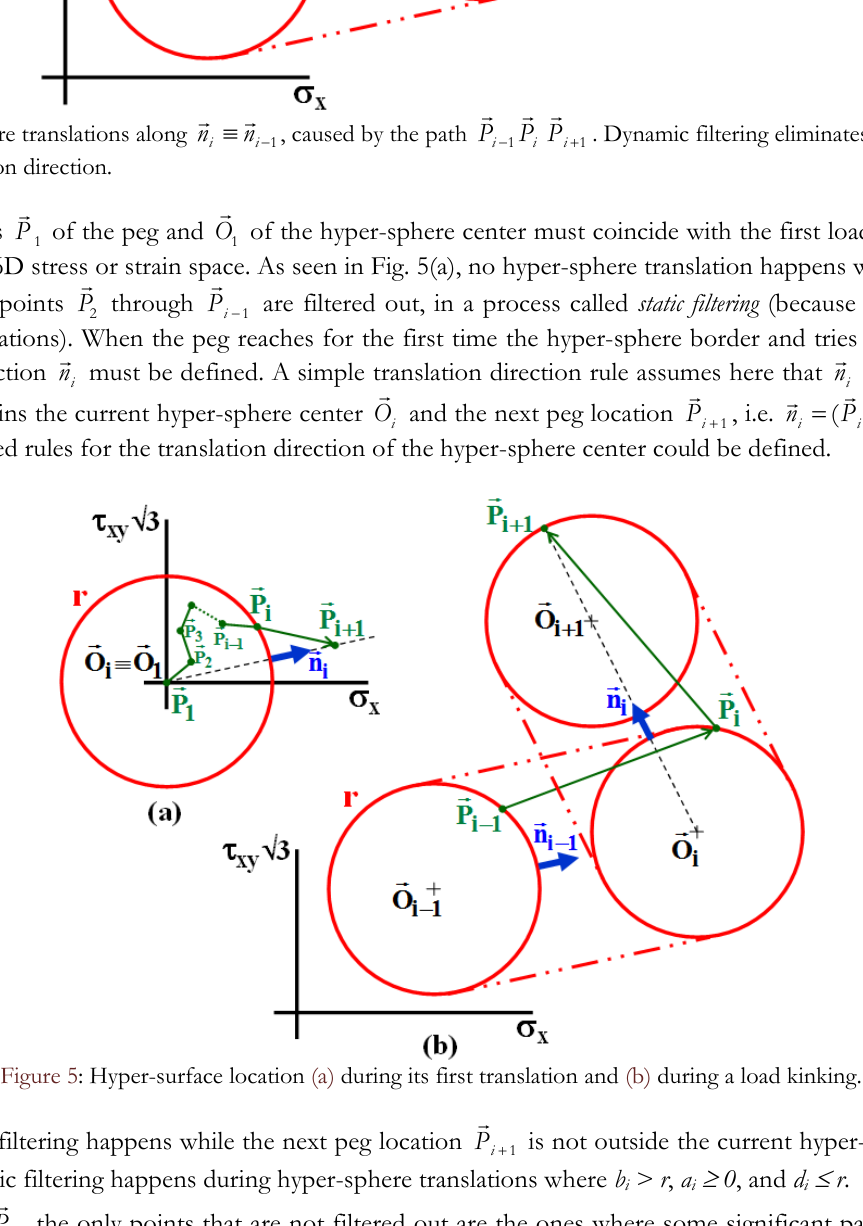
 P is not outside the current hyper-sphere, i.e. b i  r in  1 i